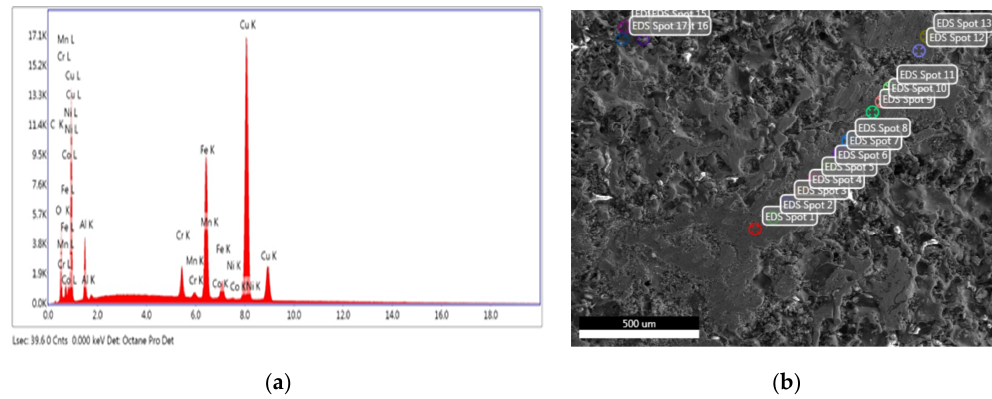
Figure 9. (a ) EDS spectra of the wear tracks on coating deposited with 359 kPa O 2 and 83 kPa of C 2 H 2 . ( b ) SEM images of the wear tracks on coating deposited with 359 kPa O 2 and 83 kPa of C 2 H 2 . The presence of Ni and Cr can be seen. In addition, the oxygen content and the increase in the wear trace are in